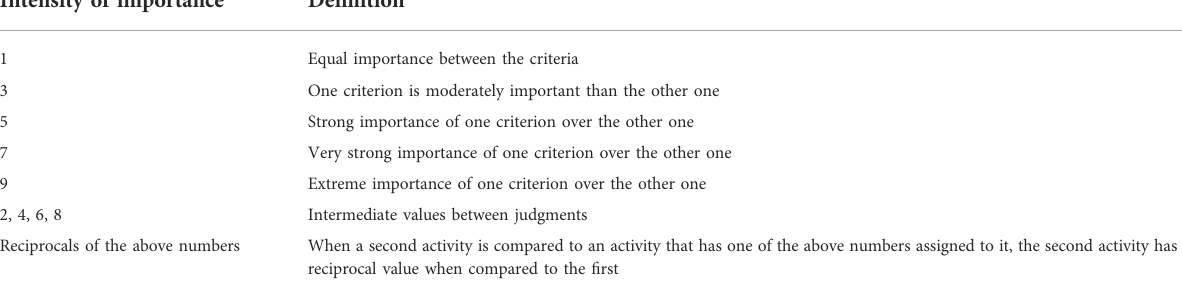
TABLE 2 Saaty ’ s ratio scale for pair-wise comparison of weights of criteria/alternatives (Saaty, 2008). Intensity of importance De fi nition